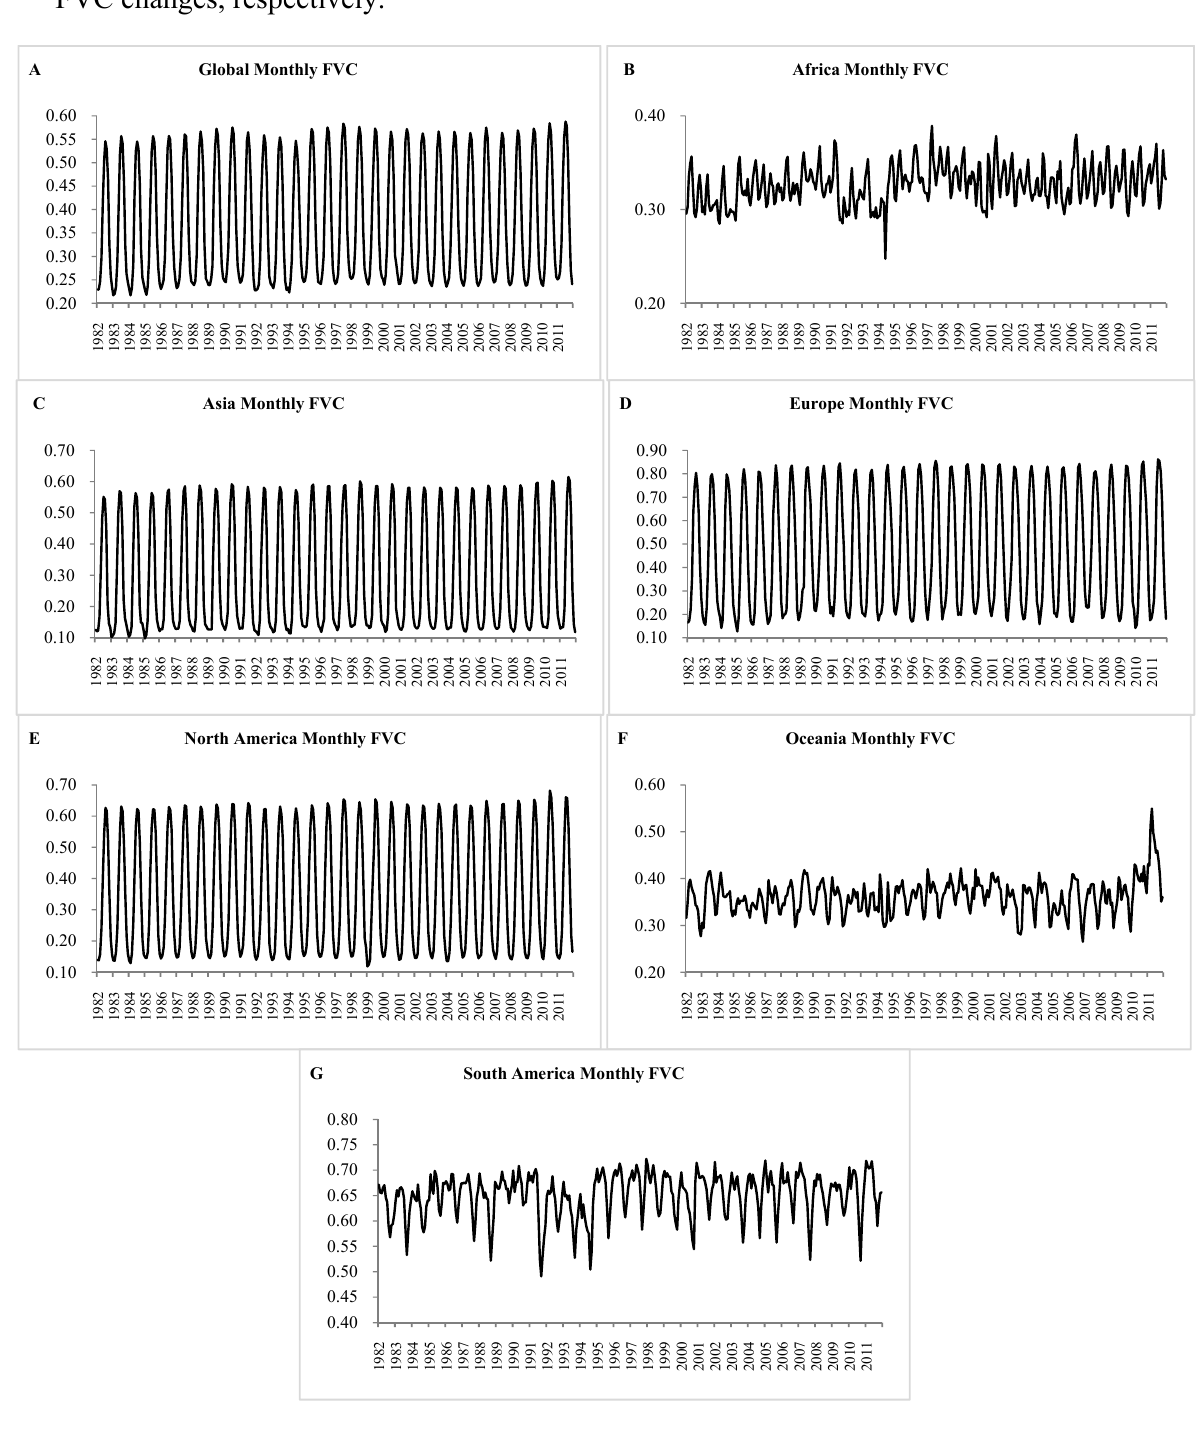
Figure 4. Monthly FVC changes of the six continents in the world from 1982 to 2011. ( A – G ) Global, Africa, Asia, Europe, North America, Oceania and South America monthly FVC changes,